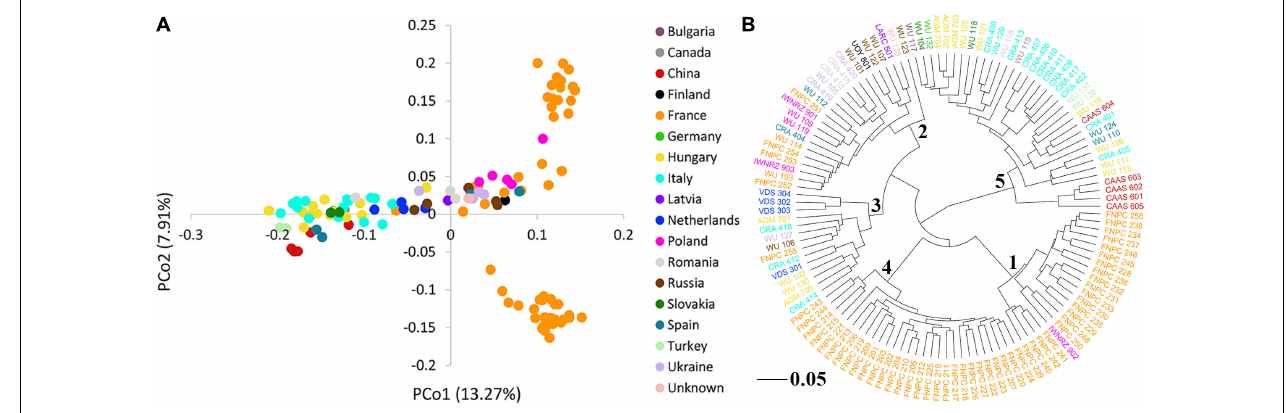
FIGURE 2 | Population structure of the 123 hemp accessions. (A) Principal coordinates analysis (PCoA) and (B) dendrogram of the kinship matrix with the number of the sub-cluster in the node. Color palette indicates the geographic origin of the accessions.